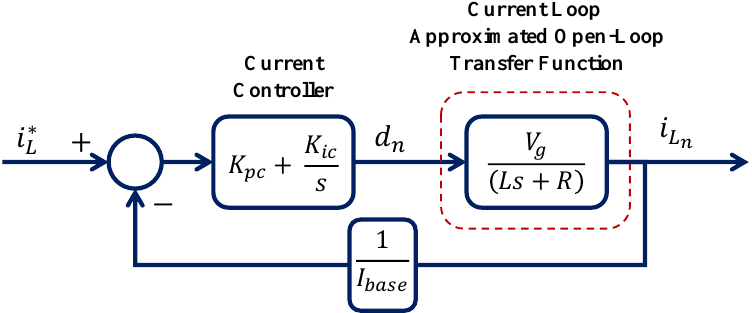
Figure 5. Current loop using the approximated open-loop transfer